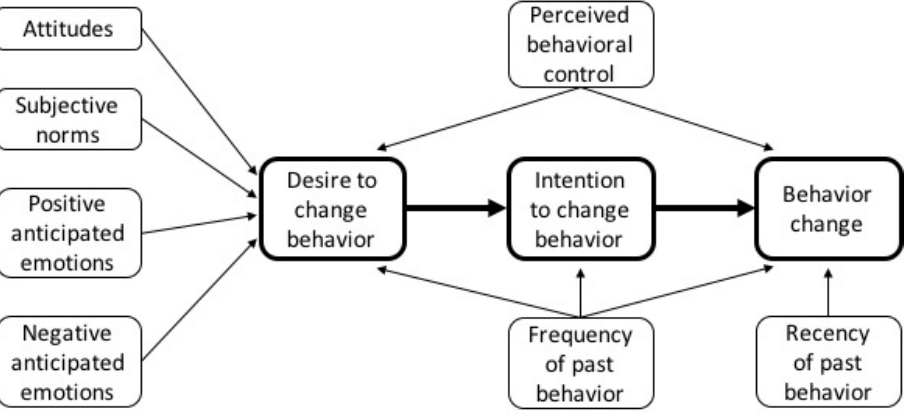
Figure 1. The Model of Goal-Directed Behavior (Perugini and Bagozzi,